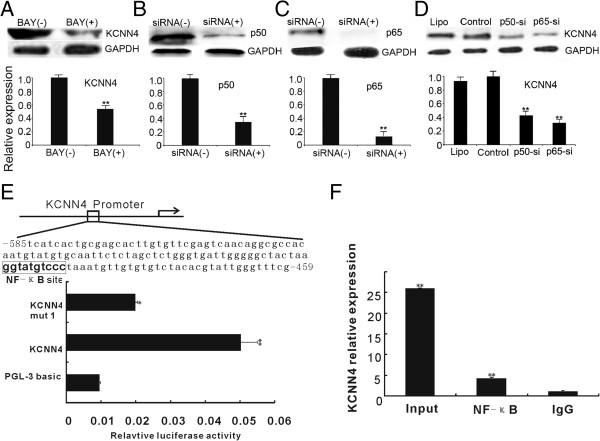
NF-κB is capable of binding to the KCNN4 gene promoter. A) Western blotting for KCNN4 of TAMs that were pretreated with or without BAY11-7082. Bars correspond to the mean ± SD, **p < 0.01, compared with no BAY11-7082 treatment. B and C) siRNAs were used to specifically inhibit p50 and p65. Bars correspond to the mean ± SD, **p < 0.01, compared with Control (non-transfected). D) Western blotting for KCNN4 of TAMs cocultured with LoVo-P cells (Control), and TAMs pretreated with Lipo2000(Lipo), p50-siRNA (p50-si), p65-siRNA (p65-si) before coculturing with LoVo-P cells. Bars correspond to the mean ± SD, **p < 0.01, compared with Control (non-transfected) and Lipofectamine 2000. E) Luciferase reporter assay demonstrated the influence of NF-κB on KCNN4 promoter activity. TAMs were cotransfected with KCNN4-promoter-luciferase plus pRL-TK-luciferase; KCNN4-promoter (mut) plus pRL-TK-luciferase; or pGL-3-basic plus pRL-TK-luciferase. Luciferase activity in cell extracts was analyzed by the Dual-Luciferase Reporter Assay System and normalized using pRL-TK-luciferase activity in each sample. Bars correspond to the mean ± SD, *p < 0.05, **p < 0.01, compared with TAMs transfected with pGL-3-basic. F) ChIP-qPCR assay confirmed that the transcription factor NF-κB can specifically bind to the regulatory region of KCNN4 in TAMs. Bars correspond to the mean ± SD, **p < 0.01, compared with isotype-matched IgG control (IgG).